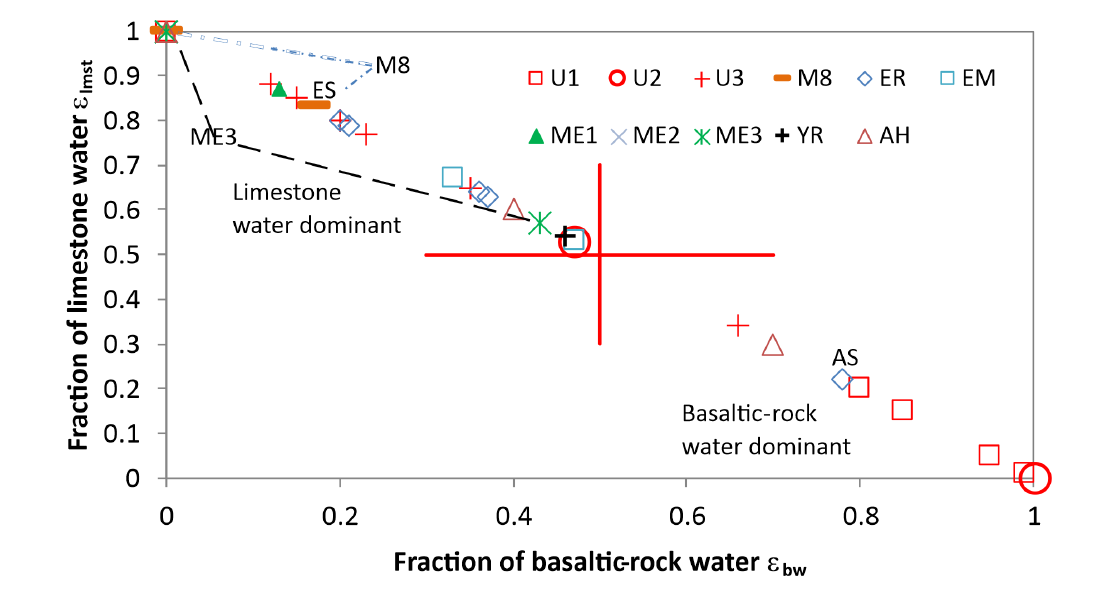
Figure 7. Cross plots of fractions of basaltic rock and limestone water in the Lower Yarmouk Gorge (LYG). Hammat Gader and Mezar are based on Golan limestone water; Muhkeibeh water is related to Ajloun limestone water. M = Mukheibeh sample.